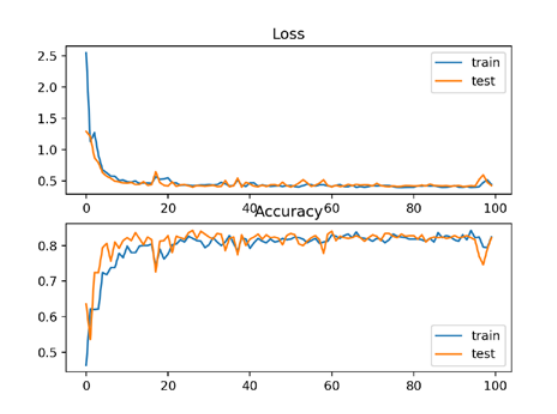
Fig. 3. Training graphs for the BLSTM neural network ensemble model. Upper graph: loss function-number of epochs; lower graph: accuracy-number of